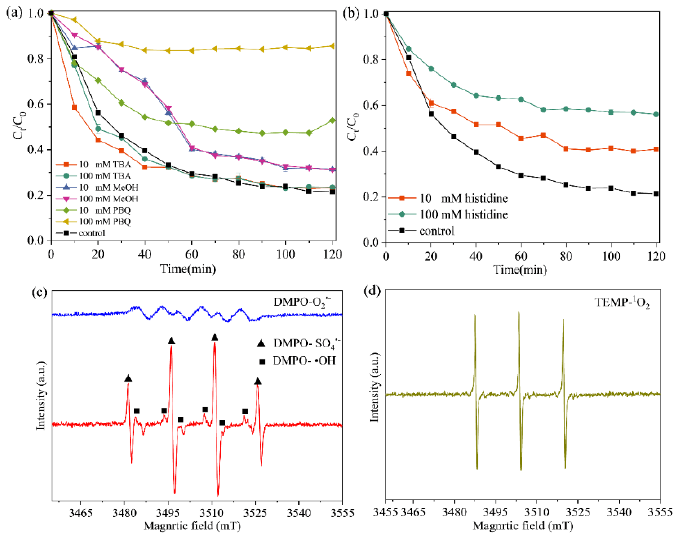
Figure 3. Quenching experiments using various scavengers in IO@ESBC/PS/TCH system ( a , b ); EPR spectra trapped by DMPO (100 mM) ( c ) and TEMP (50 µM) ( d ) at 10 min. Experimental conditions: the PS concentration of 10 mM, TCH dosage of 50 mg/L, IO@ESBC dosage of 1.25 g/L, initial pH, and temperature of 25 °C.